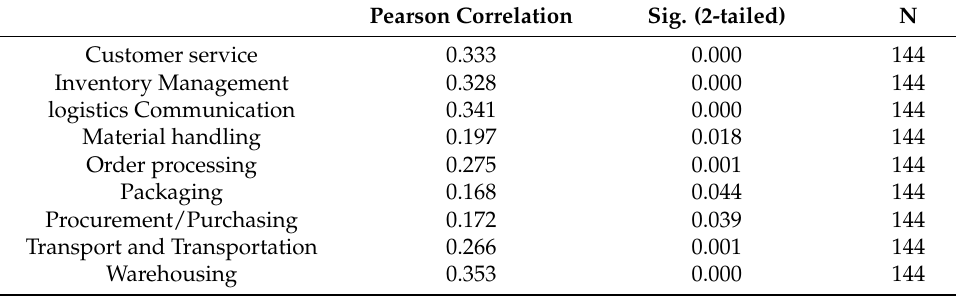
Table 10. Industry 4.0 effects on logistics